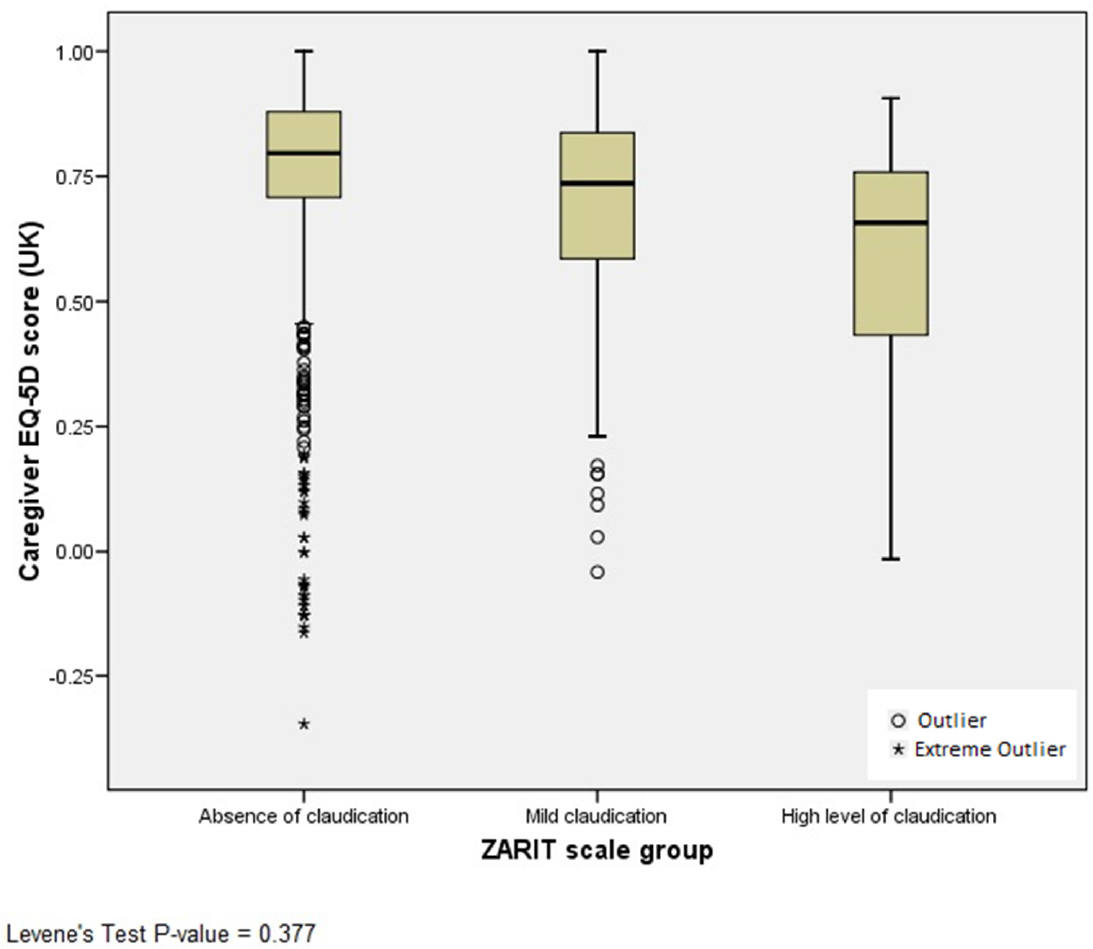
Figure 1. Box plot showing caregiver EQ-5D index (UK) of three groups of ZBI caregiver burden (Zarit scale group).